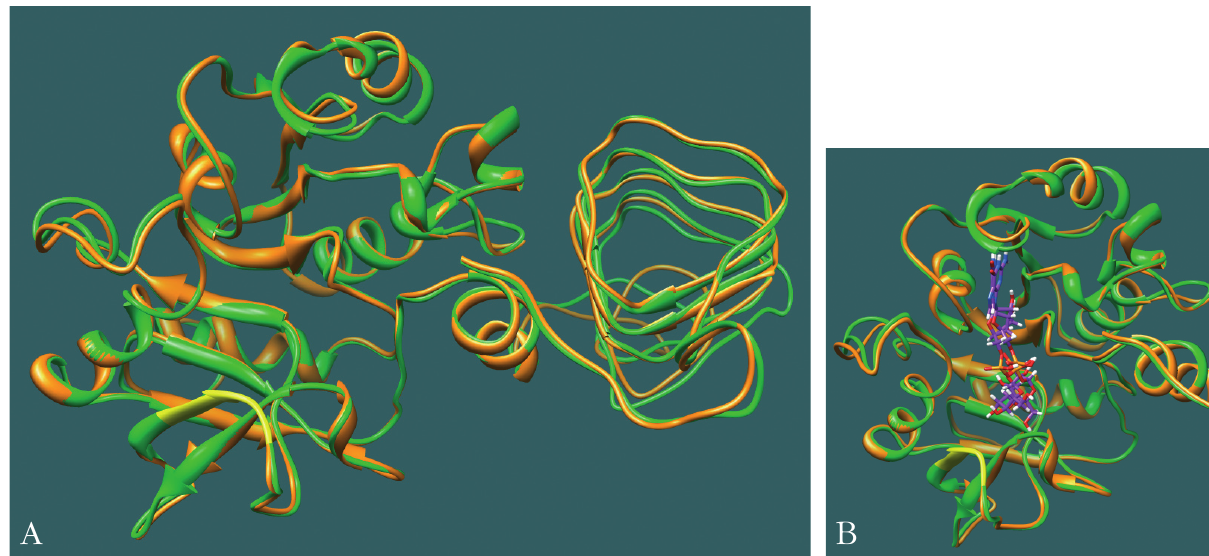
Fig. 4. – Comparison of human and L. infantum GDP-MP models. A. Superposition of human and L. infantum GDP-MP 3D models. Ribbon-tubes in green and orange represent the L. infantum and the human GDP-MPs, respectively. The F(V)EKP conserved motif is colored in yellow. B. Position of the GDP-mannose in both human and L. infantum GDP-MPs. This figure represents the superposition of both human and L. infantum GDP-MPs including the substrate GDP-mannose (purple). The position of the GDP-mannose was determined by docking. Ribbon-tubes in green and orange represent the L. infantum and the human GDP-MPs, respectively. The F(V)EKP conserved motif is colored in